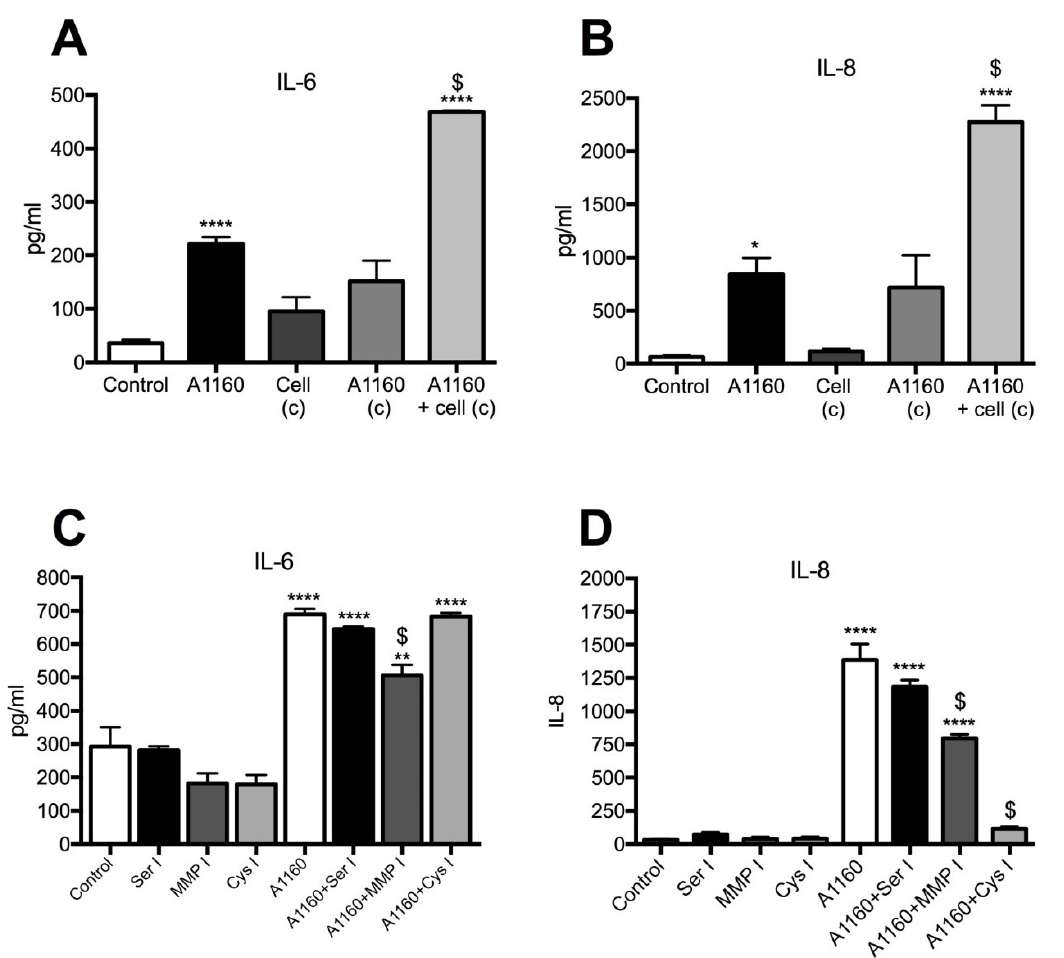
Figure 5. A. fumigatus (A1160pyrG+) metalloprotease and cysteine proteases drive cytokine induction. Conditioned media from conidia alone (A1160 c) significantly induced production of both ( A ) IL-6 and ( B ) IL-8, whereas conditioned media from A1160pyrG+-exposed cells (Af1160+cell c) induced a further production of both IL-6 and IL-8. ( C ) Serine and cysteine protease inhibitors showed no effect on IL-6 induction, whilst the MMP inhibitor partially but significantly reduced IL-6 induction. ( D ) Both MMP (MMP I) and cysteine protease (Cys I) inhibitors significantly reduced A1160+-induced IL-8 production. Data represent mean +/ − SEM, one-way ANOVA with Bonferroni multiple comparison test. **** p < 0.0001; ** p < 0.01, * p < 0.05 compared with control. $ indicates p < 0.01 for MMP I IL-6 reduction compared to A1160+-exposed cells. $ indicates p < 0.0001 for IL-8 reduction compared to A1160+-exposed cells.